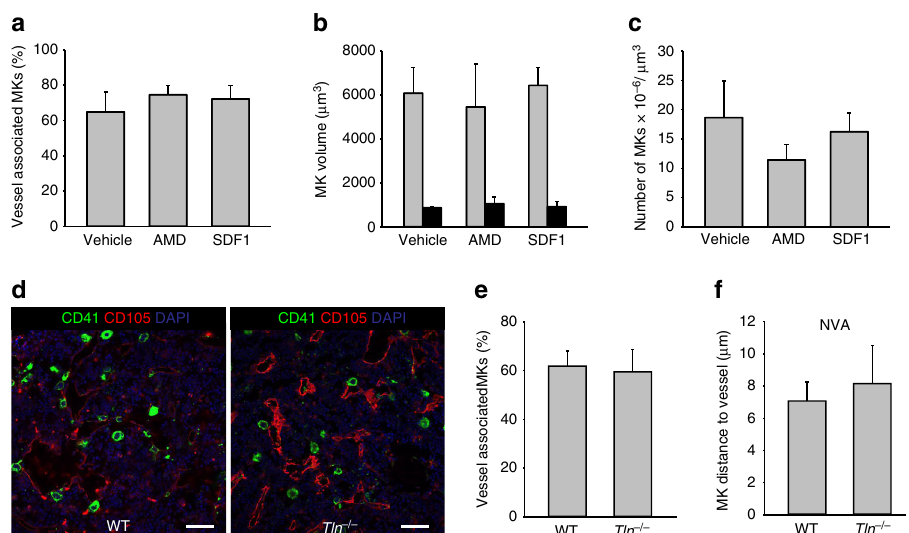
Fig. 6 CXCR4-blockade or talin-de fi ciency does not affect MK distribution within the BM. Treatment with 5 mg/kg bodyweight AMD3100 (AMD) or 16 µ g/kg bodyweight SDF1 did not modify MK localization a , volume b or numbers (four mice per group) ( c ). d , e Talin-de fi ciency ( Tln − / − ) did not affect MK distribution (Scale bar 50 µ m) or MK to vessel distances of non-vessel associated (NVA) MKs ( f ) ( n = 5 for Tln − / − , n = 4 for WT). Bar graphs represent mean ± SD. There are no signi fi cant differences ( p > 0.05; one-way ANOVA)